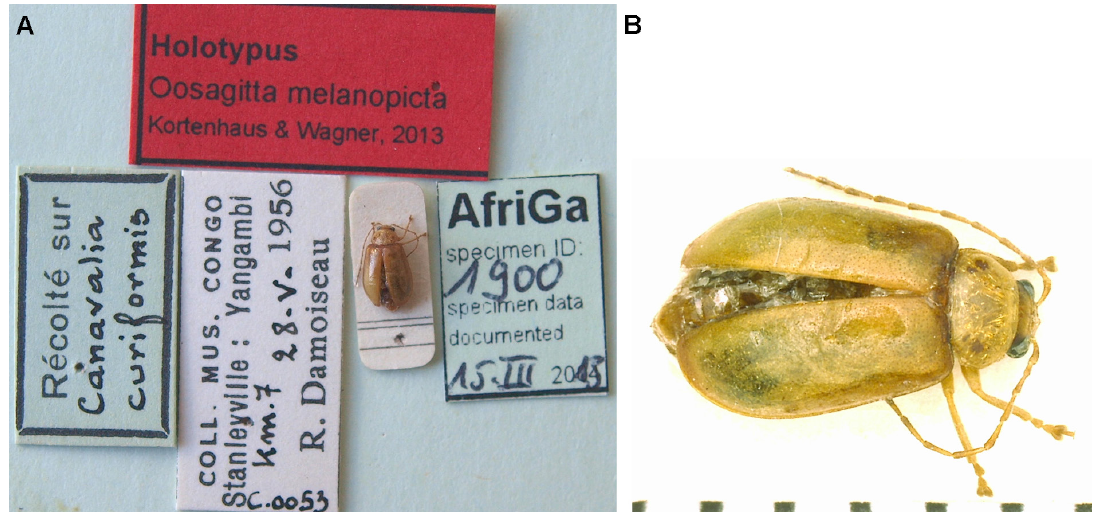
Fig. 30. Holotype of O. melanopicta sp. nov. A . Overview with labels. B . Close-up of